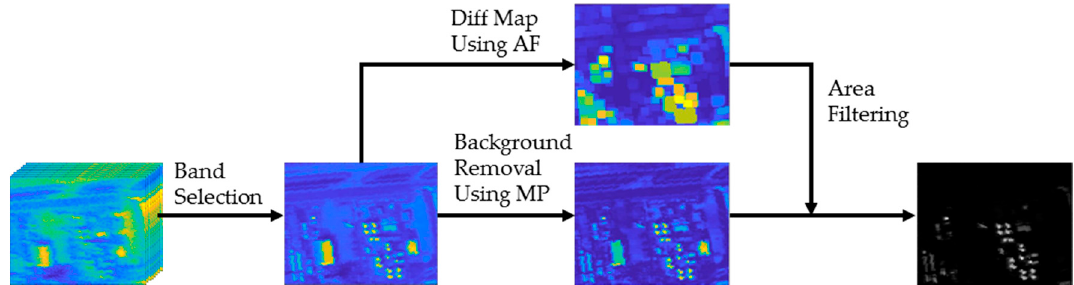
Figure 1. Schematic of morphological profile and attribute filter (MPAF) algorithm for hyperspectral anomaly detection. MP—morphological profile, AF—attribute filter.